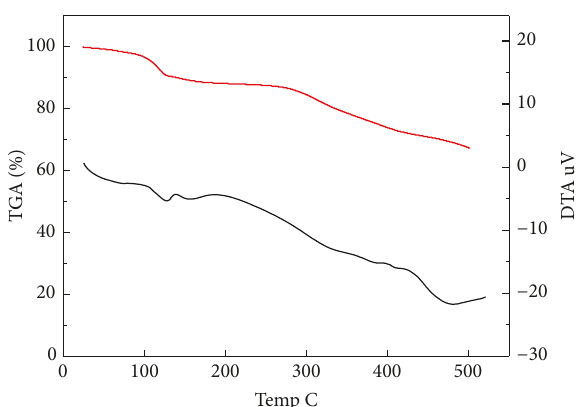
Figure 9: TGA and DTA thermograms of Nd(III) compound.